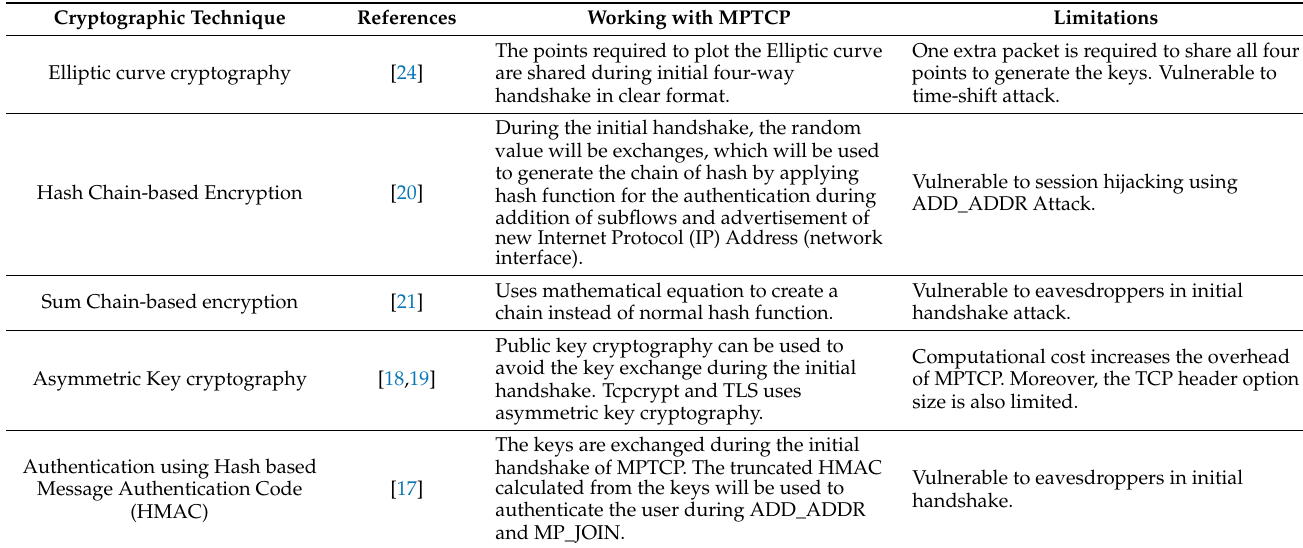
Table 1. Available cryptographic security solutions for